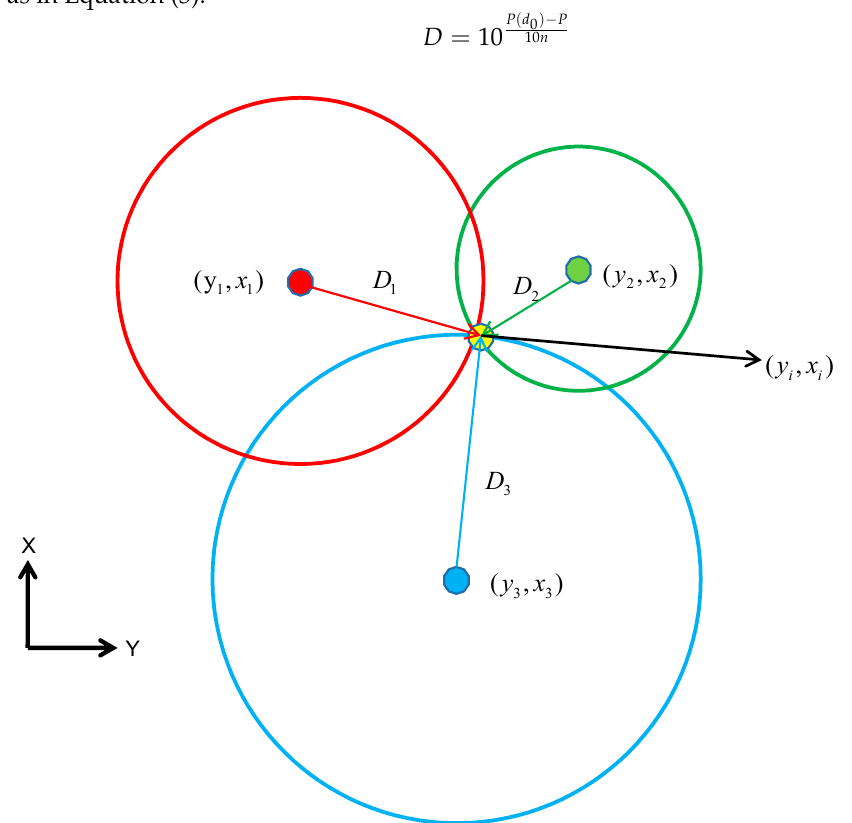
Figure 2. Trilateration using three